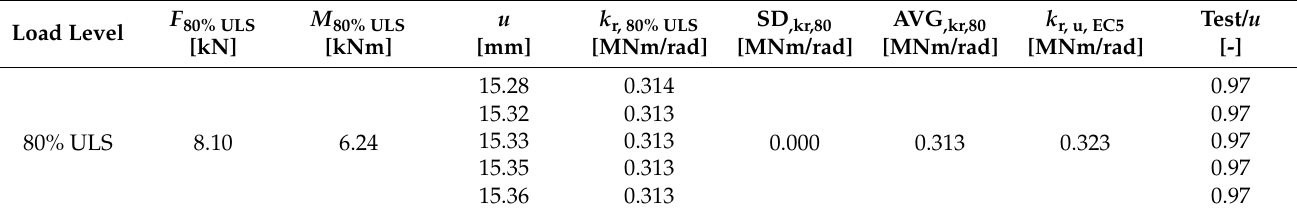
Table 10. Results of quasi-static cyclic testing for Experiment B at 80% ULS.